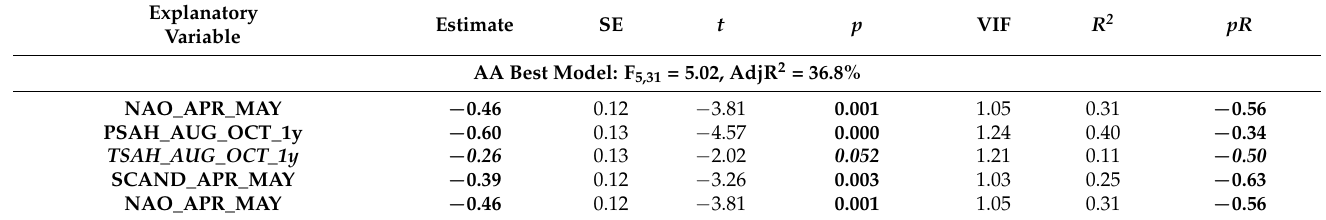
Table A13. Relationships between 15 climate variables and year and Annual Anomaly of the timing of spring migration for the Lesser Whitethroat Curruca curruca caught at Bukowo, Poland, in 1982–2021. Symbols as in Tables 1 and A12. p < 0.05 marked in bold face, 0.05 < p < 0.1 in bold italics .